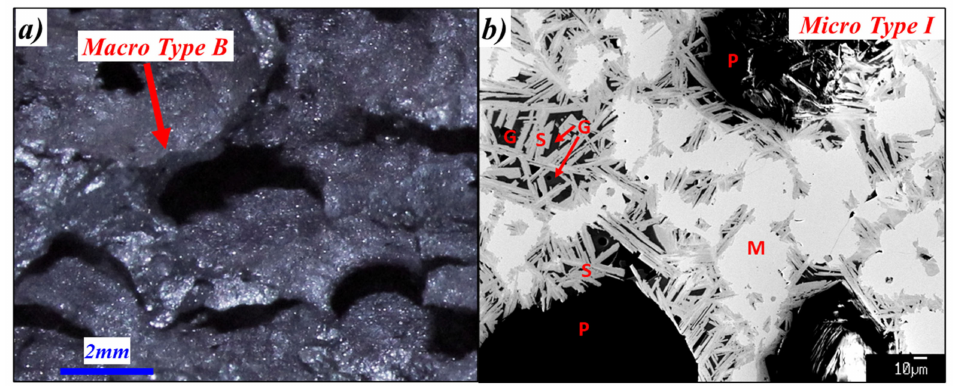
Figure 5. ( a ) Details of macro-features of type B (smooth/dull, porous, molten surface) taken by digital camera; ( b ) backscattered electron image of microstructures in Macro-Type B, G = Glass; H = Hematite; M = Magnetite; S = SFCA solid solution; D = Dicalcium silicate (C 2 S); P =